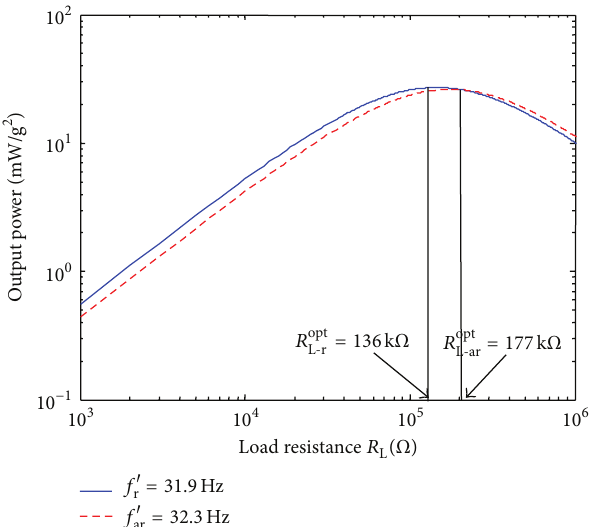
Figure 10: Output power 𝑃 0 with various 𝑅 L at resonant and antiresonant frequencies of CPEH.